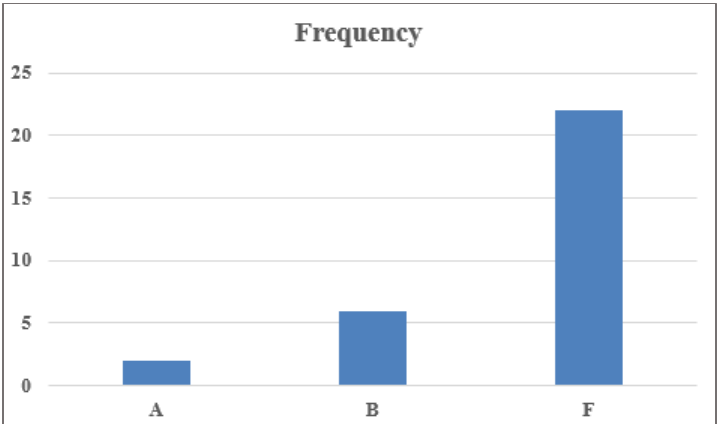
Figure 9. Frequency of the key change temporal on 13 May 2020.